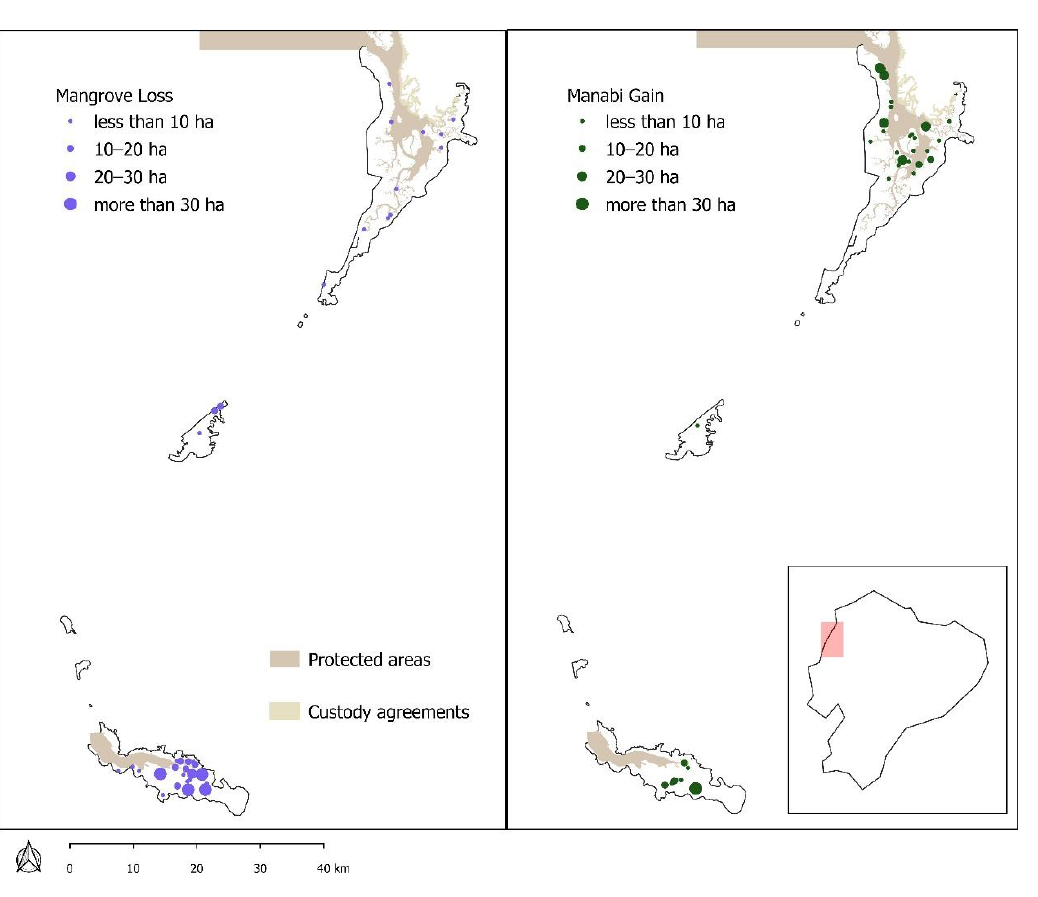
13 of 19 Figure 7. Mangrove losses and gains in the Esmeraldas province between 1998 and 2016.